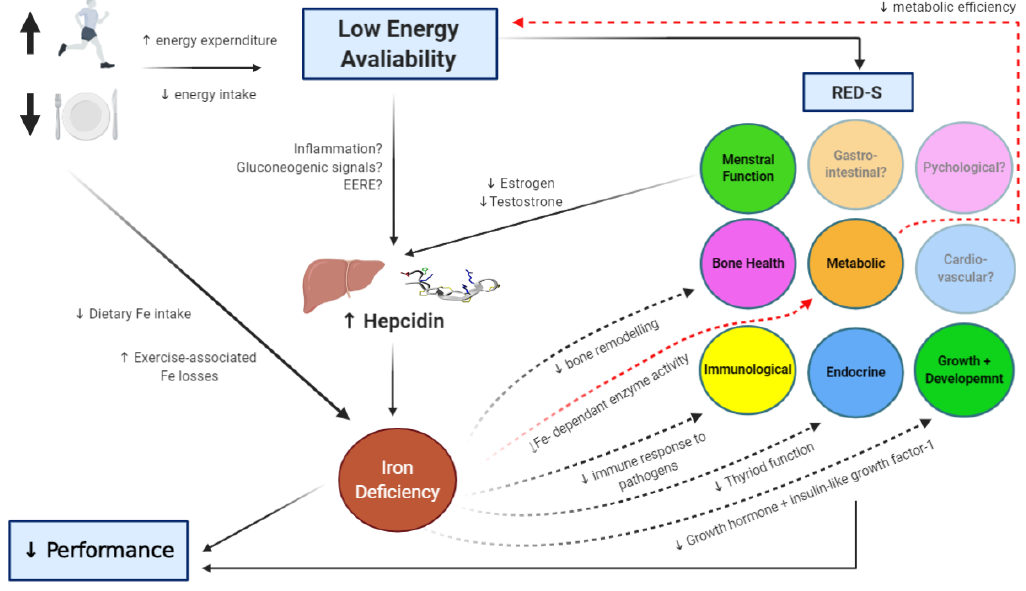
Figure 1. Schematic representation of the interactions between low energy availability (LEA) and iron status in athletes. Solid lines identify pathways where LEA is thought to affect iron status, often mediated by hepcidin expression. Broken lines indicate how iron deficiency can exacerbate other health consequences associated with LEA in relation to the Relative Energy Deficiency in Sport syndrome (RED-S) [6].